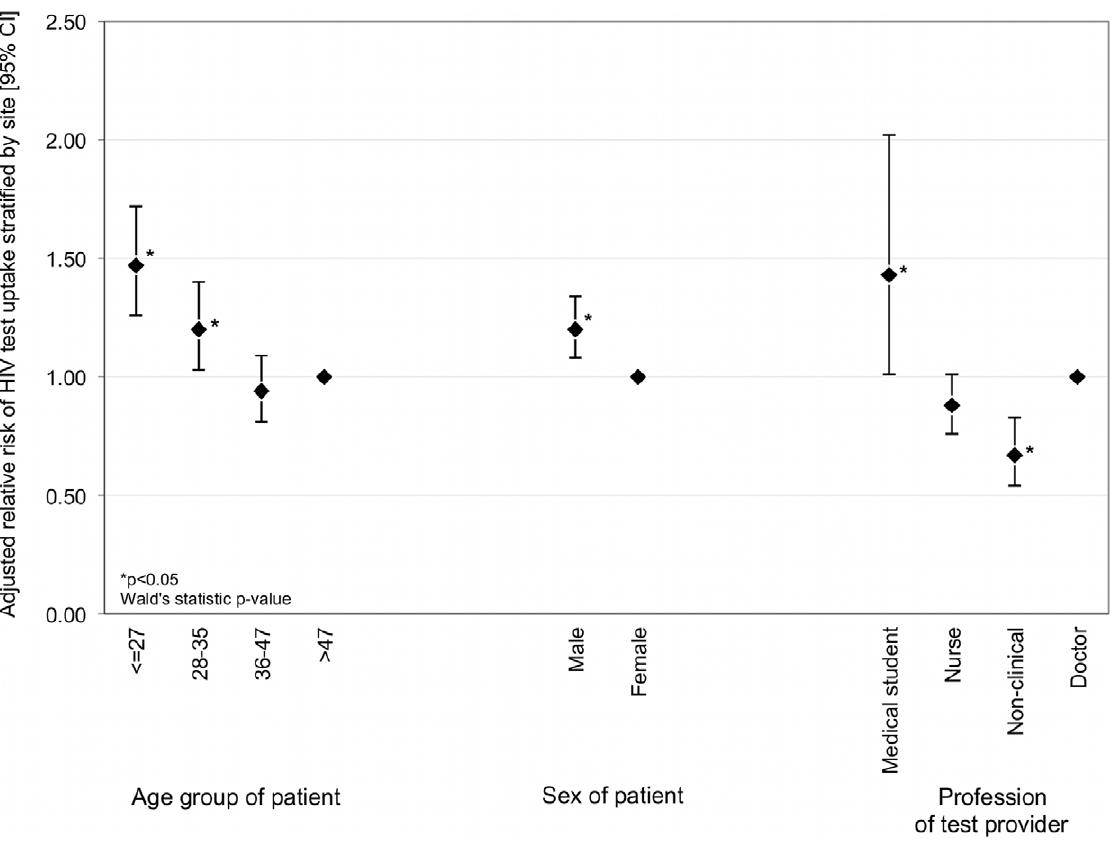
Figure 2. Multivariable logistic regression model showing significant independent predictors of HIV test uptake in patients who were offered the test. (n=6194; adjusted for ethnicity, and other variables in the model, and stratified by site).